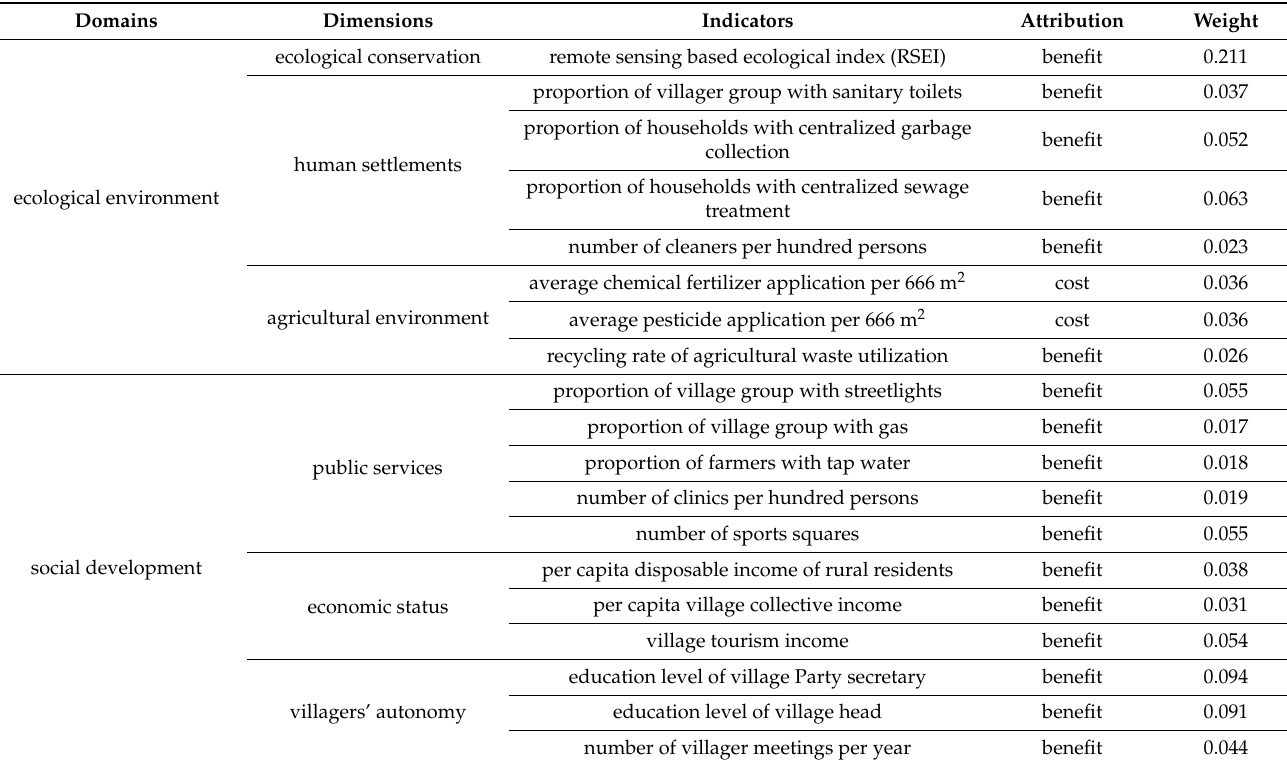
Table 1. The indicator system for the IERSE of Wenchuan